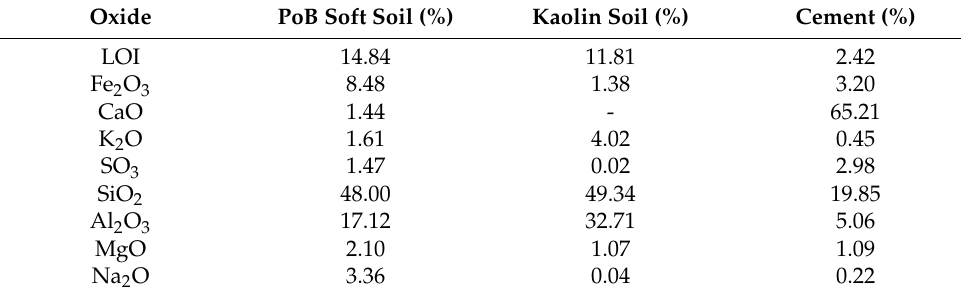
Table 2. Chemical composition of the